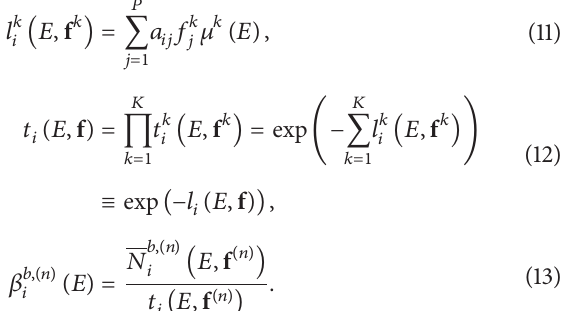
Figure 1: One-dimensional illustration of the optimization transfer principle. 𝑄(𝑓;𝑓 (𝑛) ) is a surrogate function to the objective function Φ(𝑓) at iteration step ( 𝑛 ). Hence, it is tangential to Φ(𝑓) at 𝑓 (𝑛) . The abscissa of the minimum of 𝑄(𝑓; 𝑓 (𝑛) ) is the new estimate 𝑓 (𝑛+1) . It in turn marks the position where the next surrogate function 𝑄(𝑓; 𝑓 (𝑛+1) ) is constructed, tangential to Φ(𝑓)